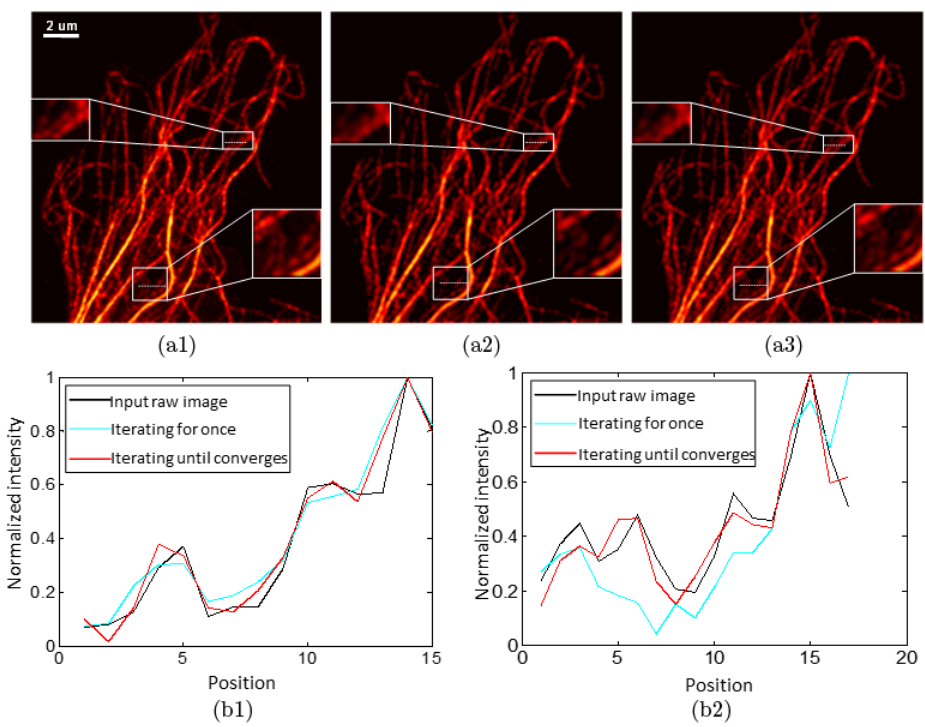
Fig. 6. Simulation results for a microtubule with 59% overlapping area in frequency domain. (a1) The input raw image of the sample. (a1) – (a2) FPM's recovery iterated for only once and ¯ve times until the solution converges, respectively. (b1) – (b2) Intensity pro¯les alone the upper and lower white dotted lines in (a),